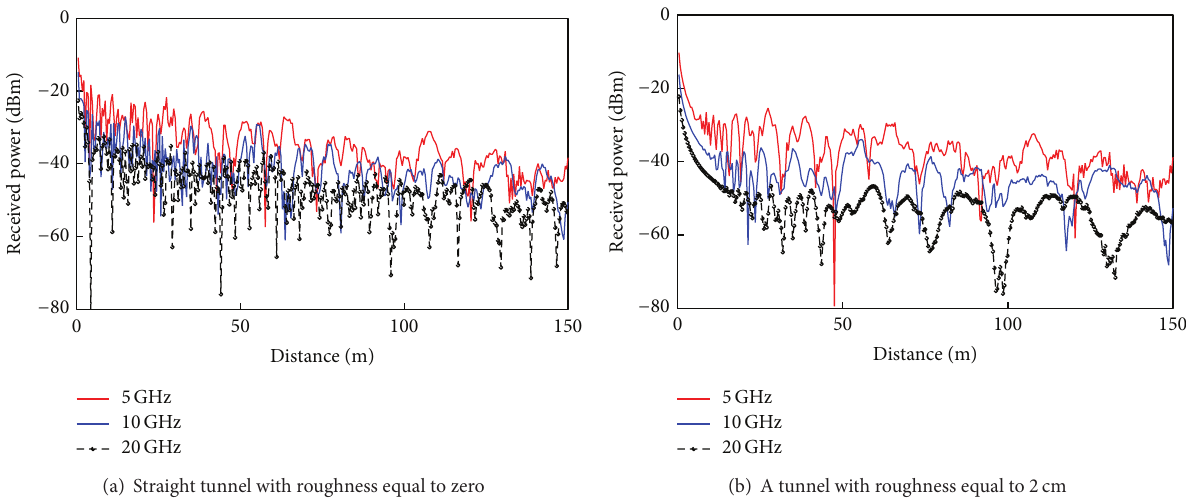
Figure 8: Received power levels with the transmitter’s frequency changed.